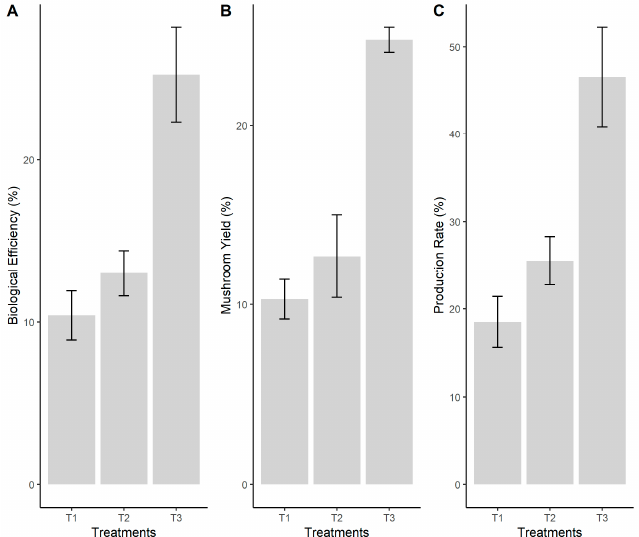
Figure 1. Mushroom Growth analysis in function of the growth media: ( A ) Biological Efficiency (%), ( B ) Mushroom Yield (%), ( C ) Production Rate (%). Legend: T1—pine sawdust; T2—coconut coir; T3—waste paper .